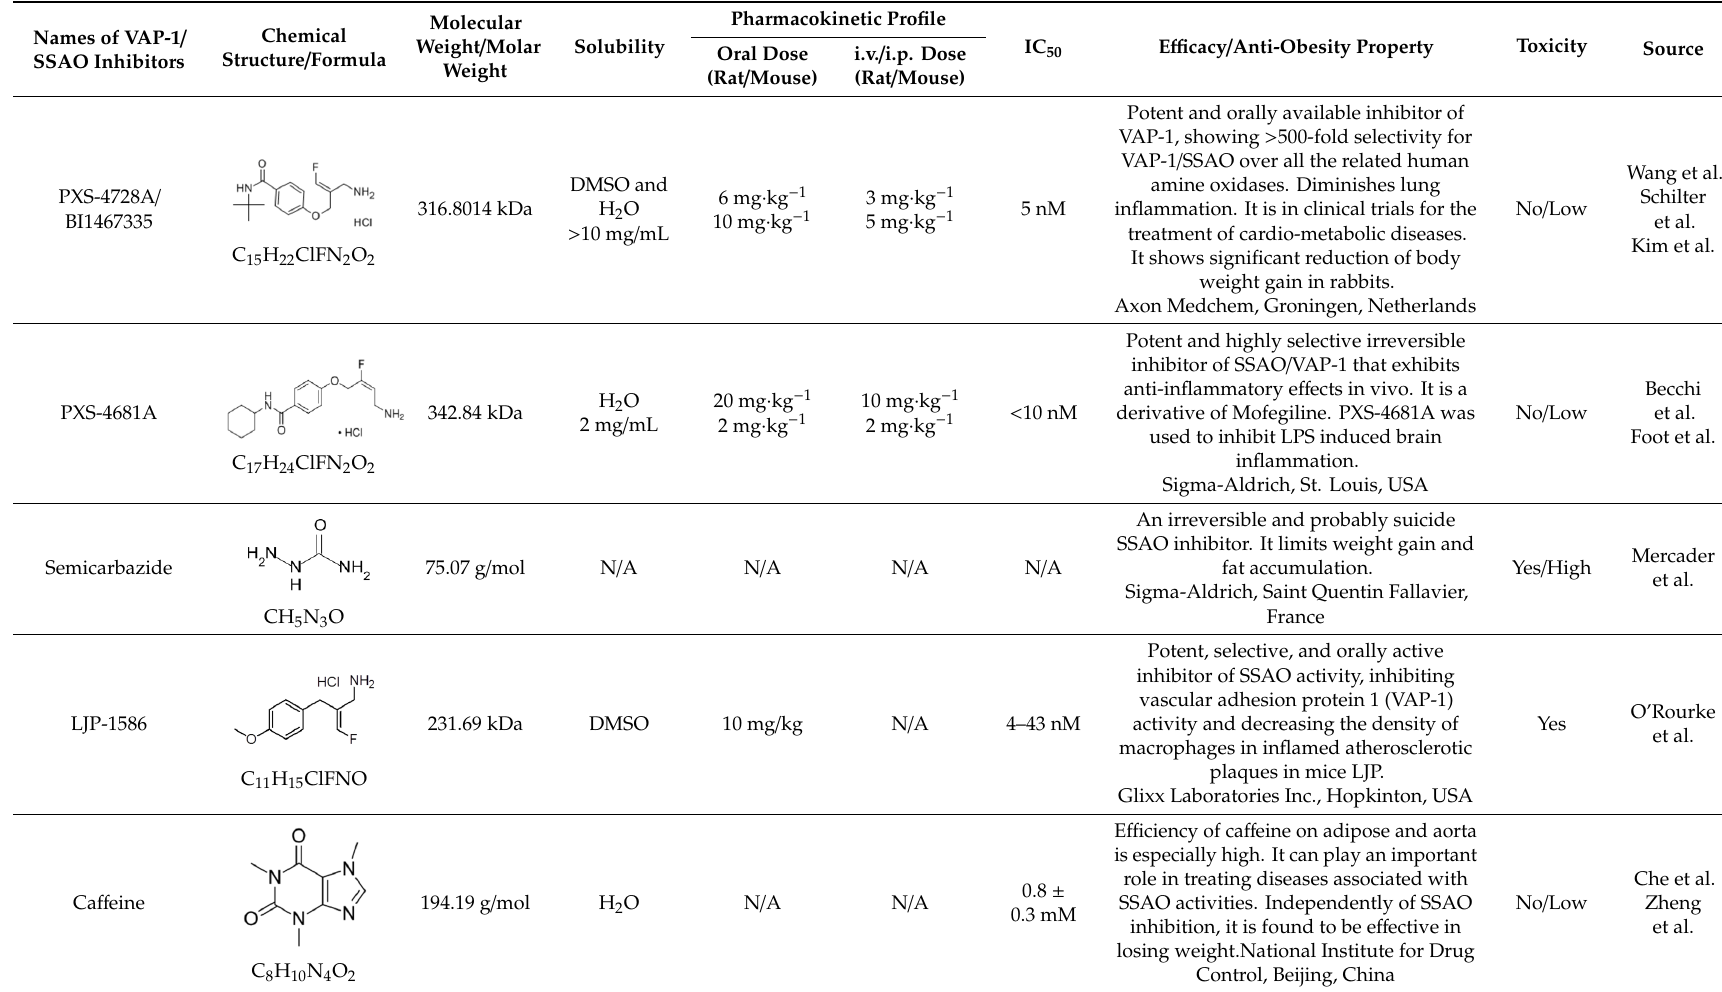
Table 1. Description of semicarbazide-sensitive amine oxidase/vascular adhesion protein-1 (SSAO/VAP-1) inhibitors according to chemical and pharmacological properties.